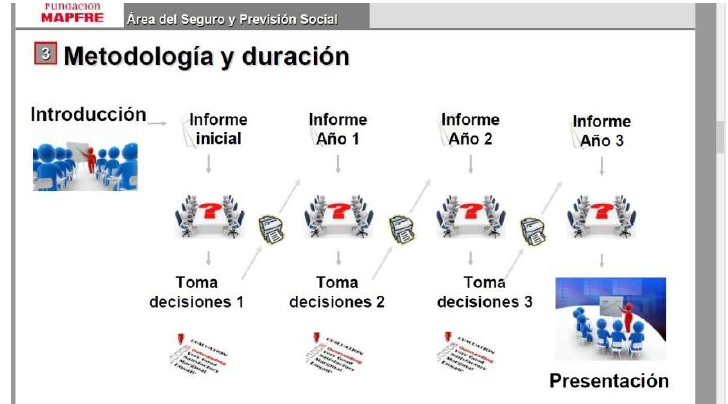
Figure 3. The four stages of the BugaMap game. Source: Fundación MAPFRE [29].